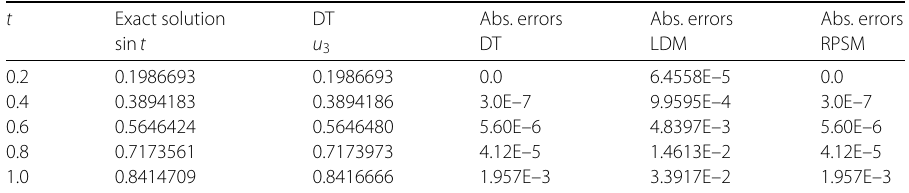
Table 3 Error analysis of u 3 on